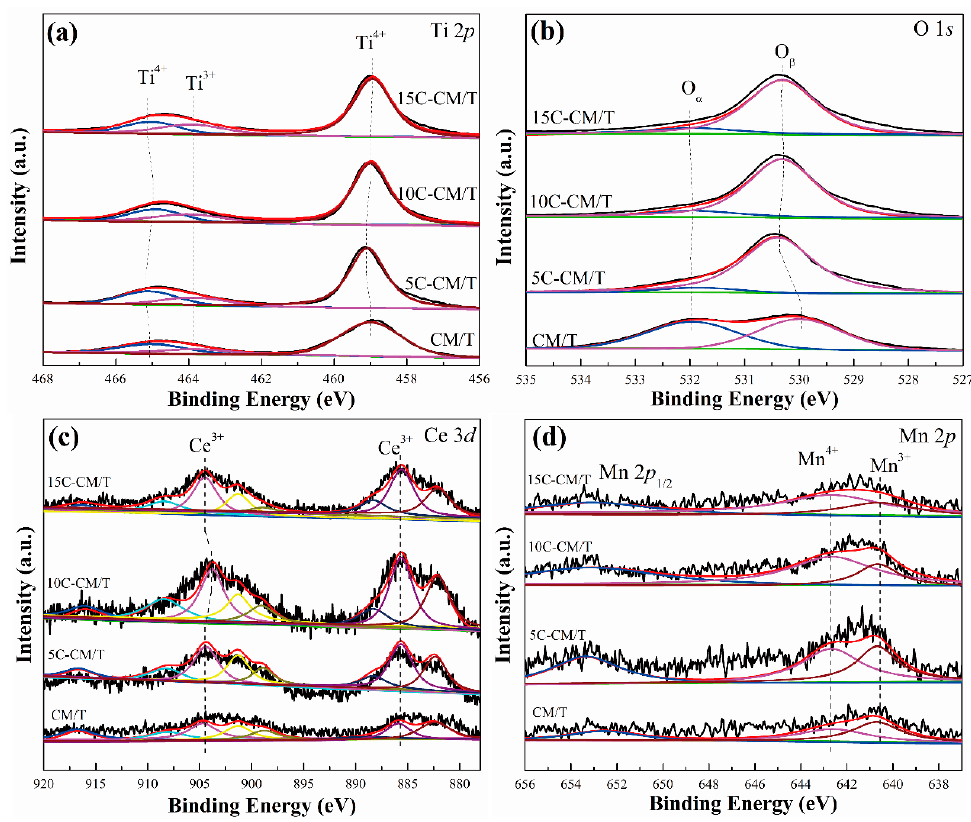
Figure 8. ( a ) Ti 2 p , ( b ) O 1 s , ( c ) Ce 3 d, and ( d ) Mn 2 p XPS spectra of CM/T, 5C-CM/T, 10C-CM/T, and 15C-CM/T.